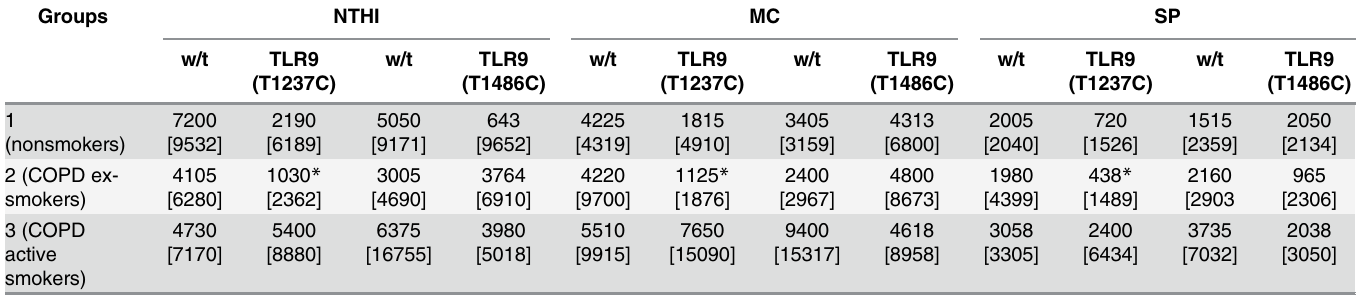
Table 6. Alveolar macrophage IL-8 (pg/ml) induction of alveolar macrophages expressing wildtype (w/t), TLR9 (T1237C) and TLR9 (T1486C). IL-8 values are expressed as median [IQR] and correspond with data of Figs 2 and 3.